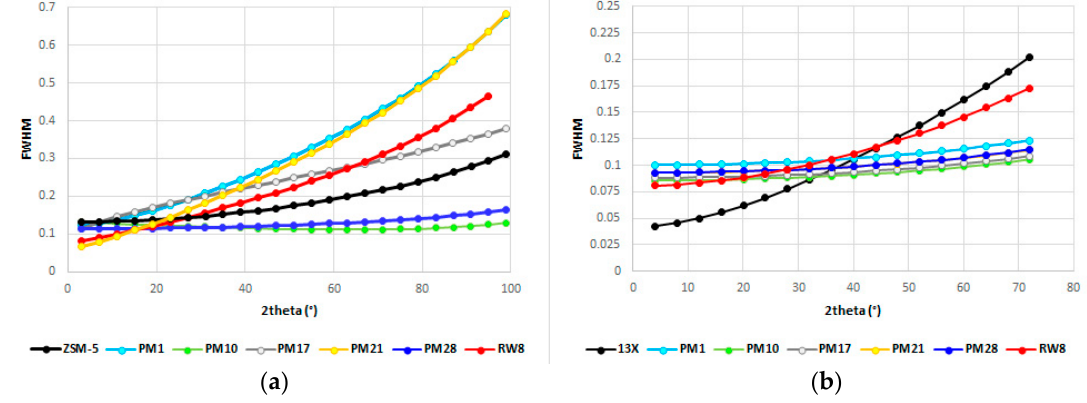
Figure 3. FWHM values as a function of 2theta (°) of ZSM-5 ( a ) and 13X ( b ) .